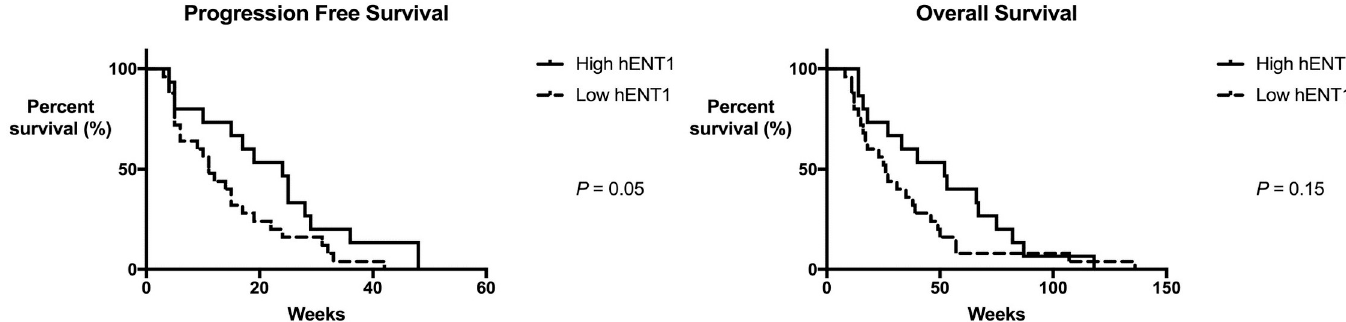
Fig 6. (A) Median progression-free survival (PFS) of patients administered gemcitabine and cisplatin combination chemotherapy. There was borderline significance of the difference in PFS between high- and low-hENT1 groups (24 and 11 weeks, P = 0.05). (B) Median overall survival of patients who received gemcitabine and cisplatin combination chemotherapy. There was no significant difference in overall survival between high- and low-hENT1 groups (52 and 26 weeks, P =